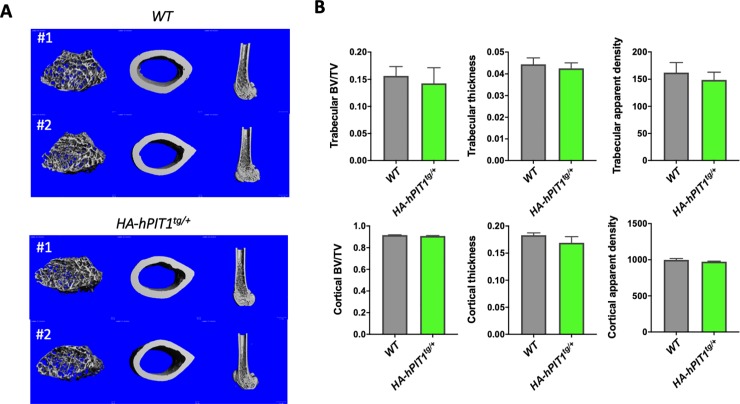
uCT analysis of P80 HA-hPIT1 transgenic mice.Representative μCT images of two WT and HA-hPIT1tg/+ 80 day old males (A) and quantification of trabecular and cortical parameters (B) shows no significant effect of HA-hPIT1 overexpression. Means±SEM, n = 4 mice.